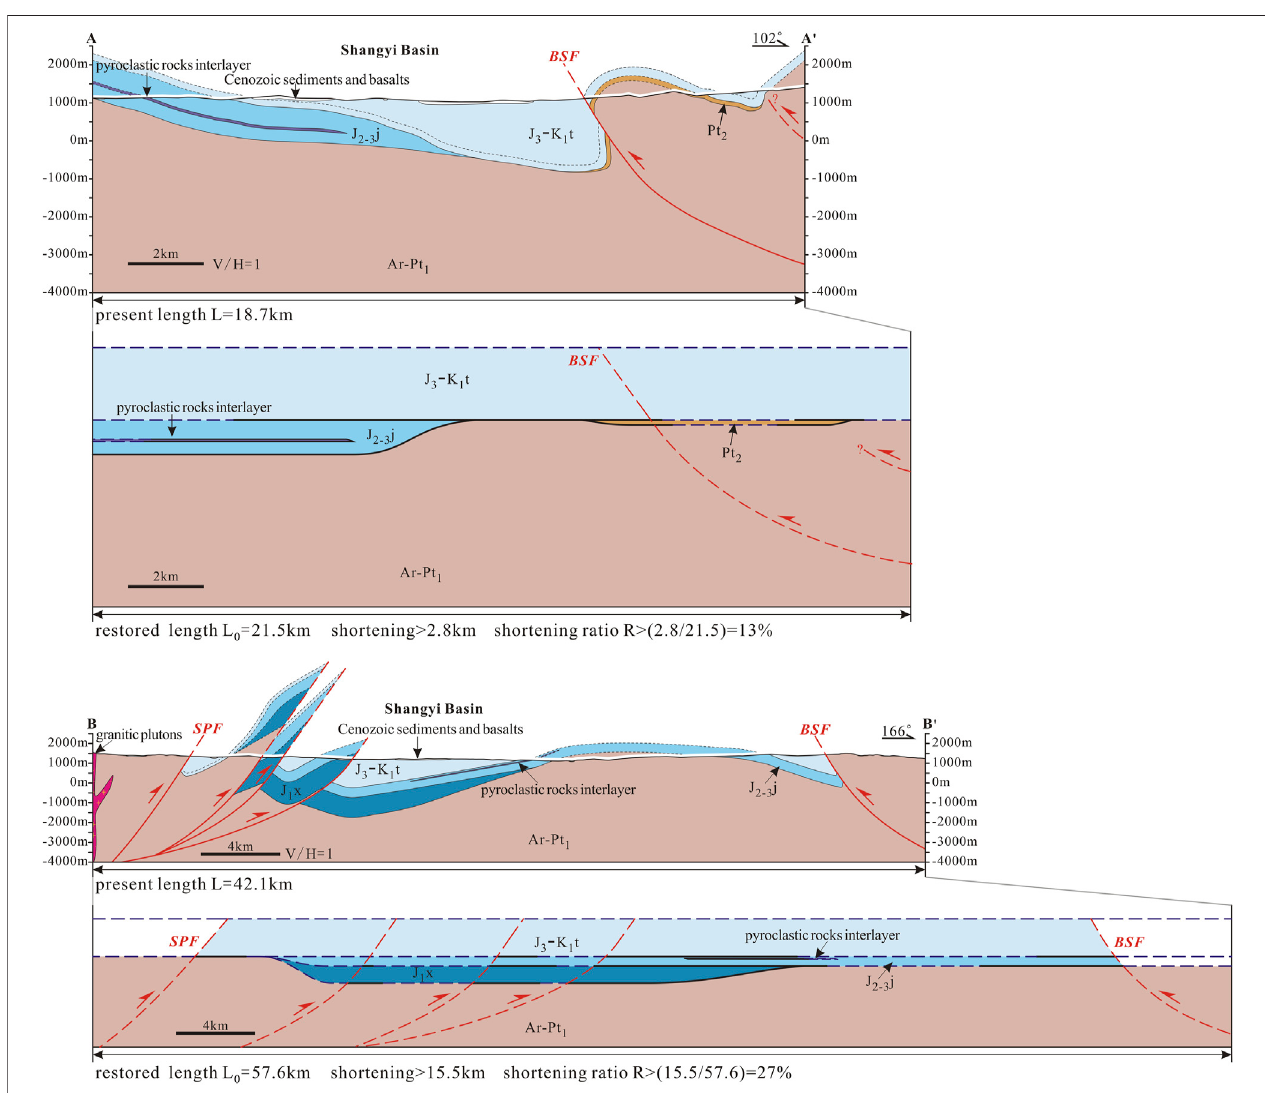
FIGURE 10 | The results of balance and restoration of the sections A-A ’ and B-B ’ . Subsurface geometries are largely schematic due to lack of geophysical data. The legends are the same as Figure 2B . The rest fi gure captions are the same as Figure 1B .